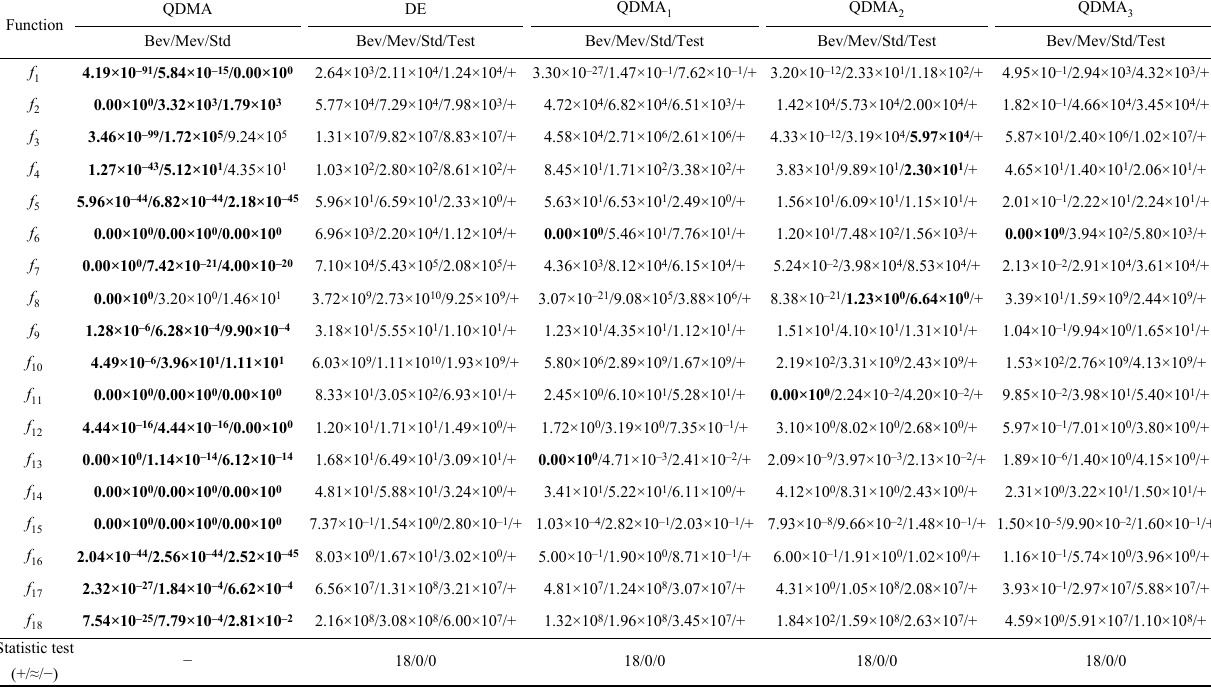
Table 6 Comparison of QDMA and its special designs on 50 D